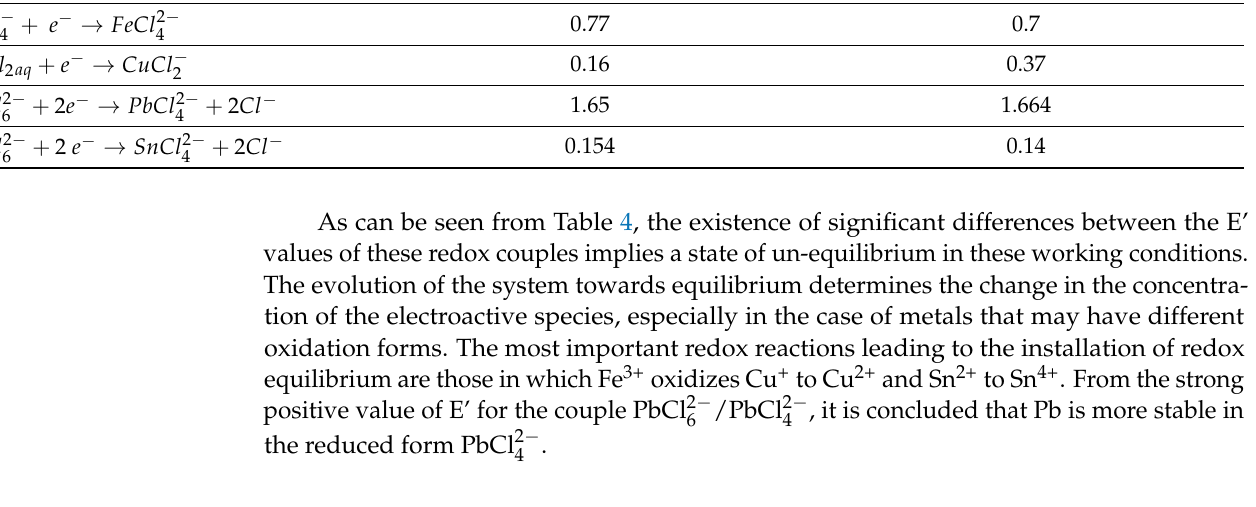
Table 4. E’ values for PAR that involve the complexation of both forms of the redox couple. Potential Active